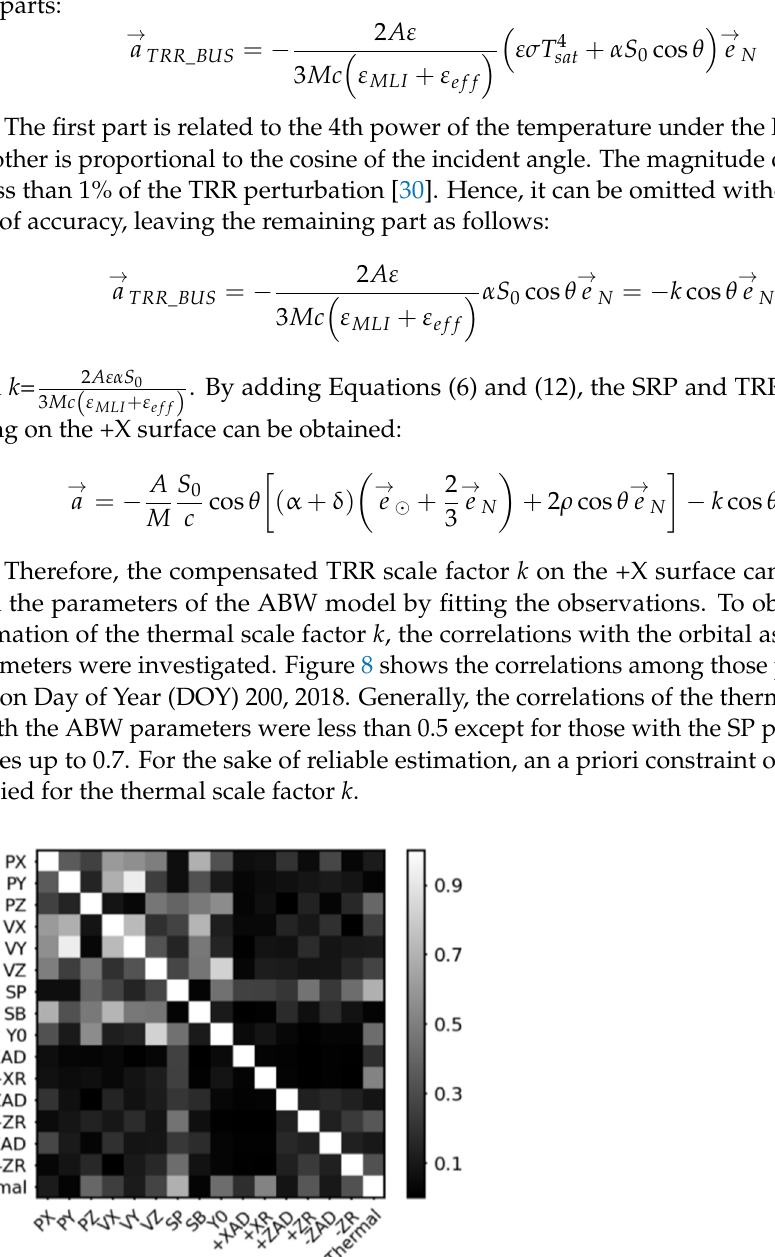
Figure 9. Daily estimates of the thermal scale factors for C13 with distribution on the β angle. (The grey represents the eclipse season).